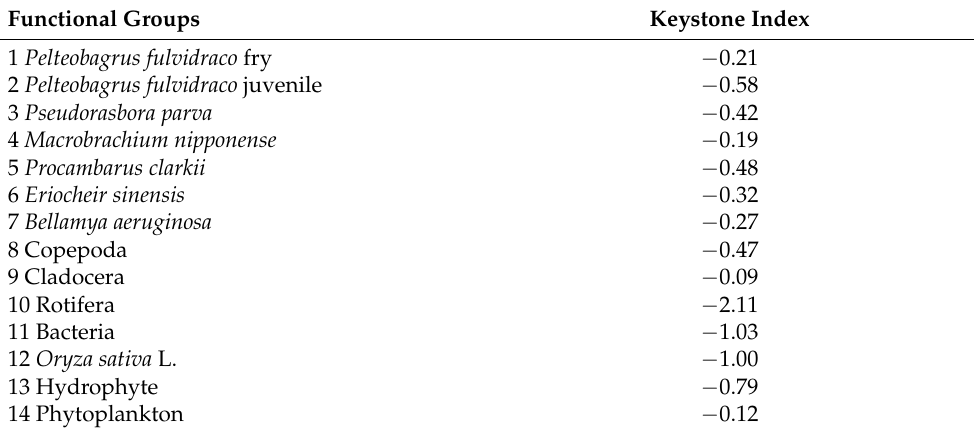
Table 5. Overall impact and keystone indexes of the FMRP.